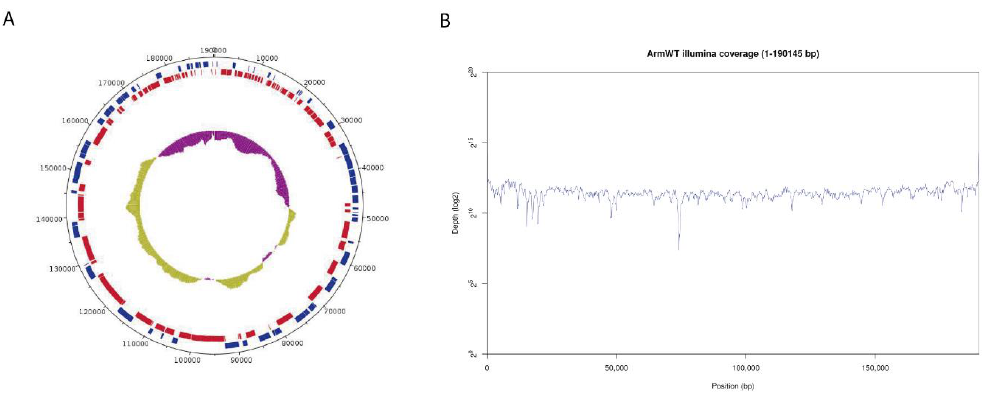
Figure 2. Genome assembly of Arm / 07 / CBM / c2. ( A ) Circular representation of the genome indicating predicted CDS in “forward” (blue) or “reverse” (red) orientation in the outer circle and the GC/AT (purple indicates higher AT content, green indicates higher GC content) in the inner circle. ( B ) Whole genome coverage plot using Illumina sequencing reads mapped to the ASFV Arm / 07 / CBM / c2